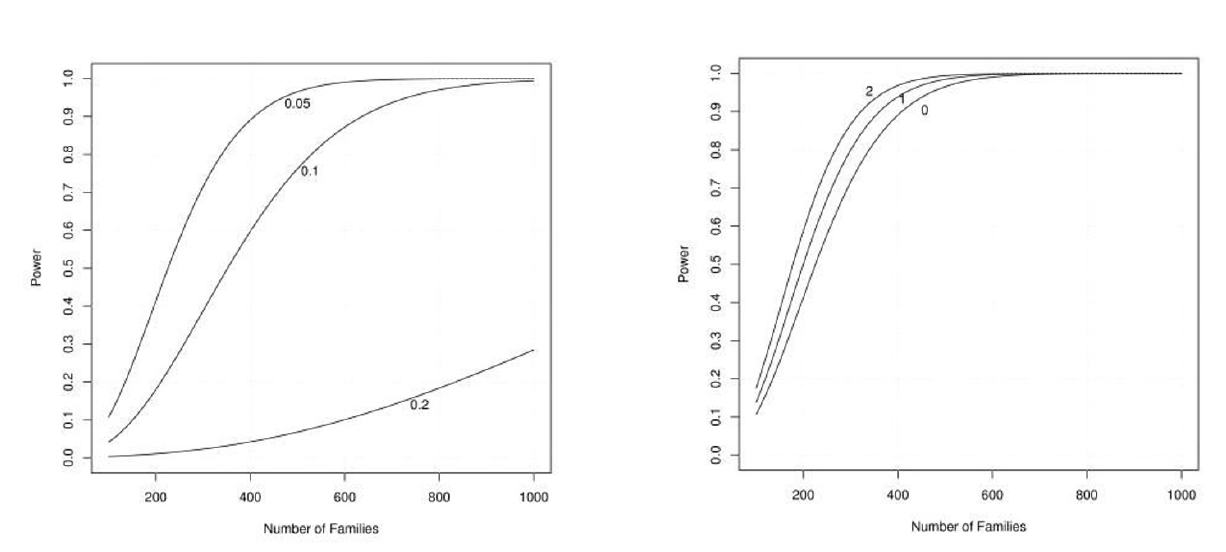
Figure 4 Effect of sample size and varying number of typed parents on estimated power.